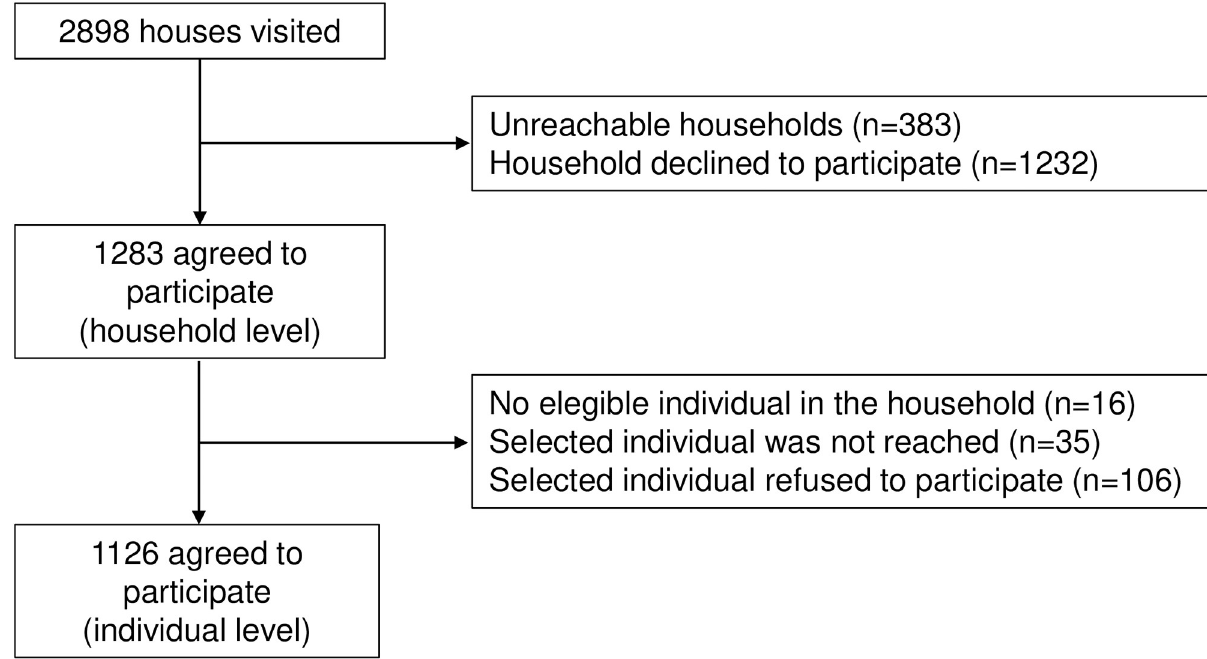
Fig 2. Flowchart of the study selection